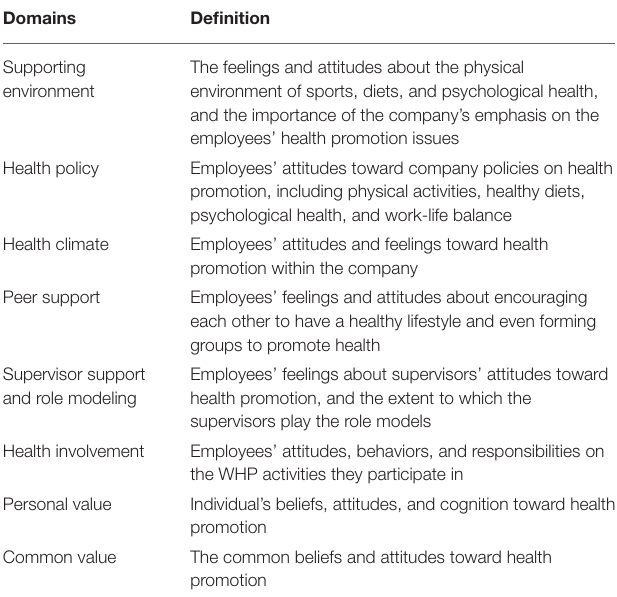
TABLE 1 | Definitions of the workplace health culture scale (first